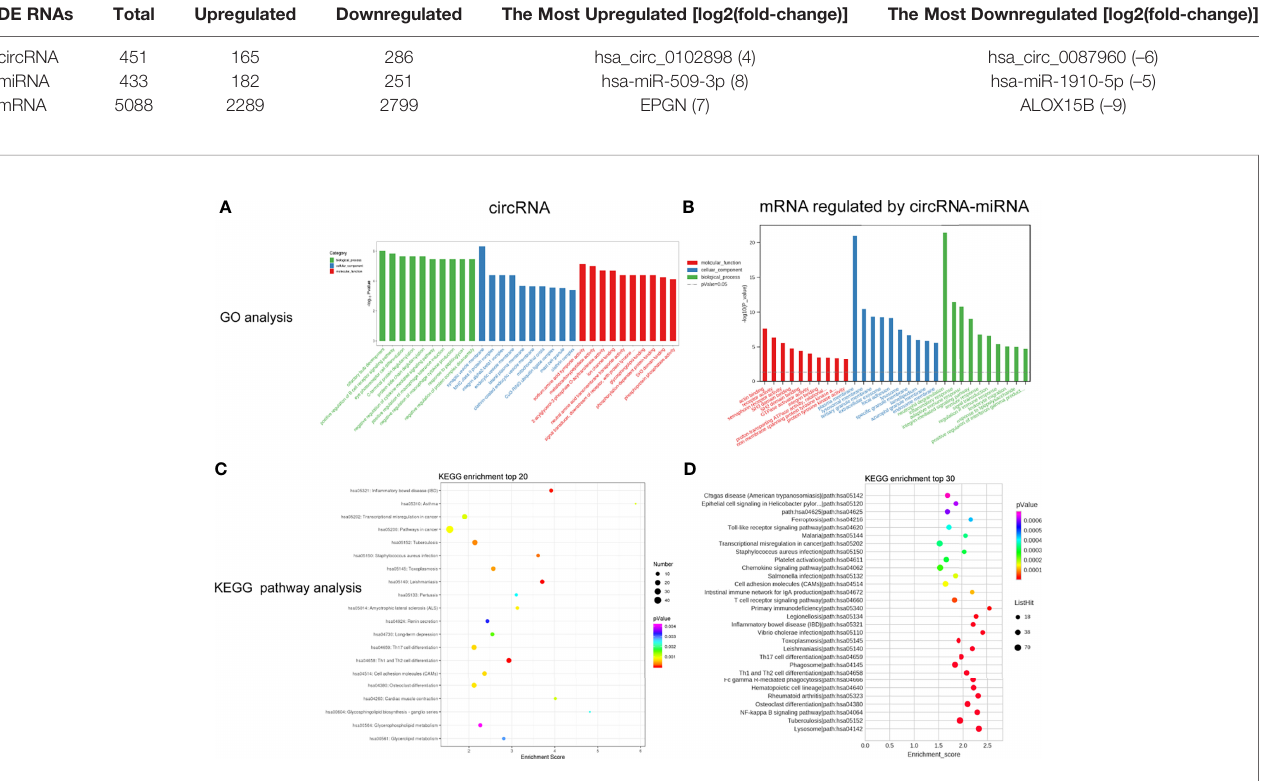
FIGURE 4 | GO enrichment analysis and KEGG pathway analysis for the differently expressed circRNAs (A, C) and mRNAs regulated by circRNA-miRNA (B, D)